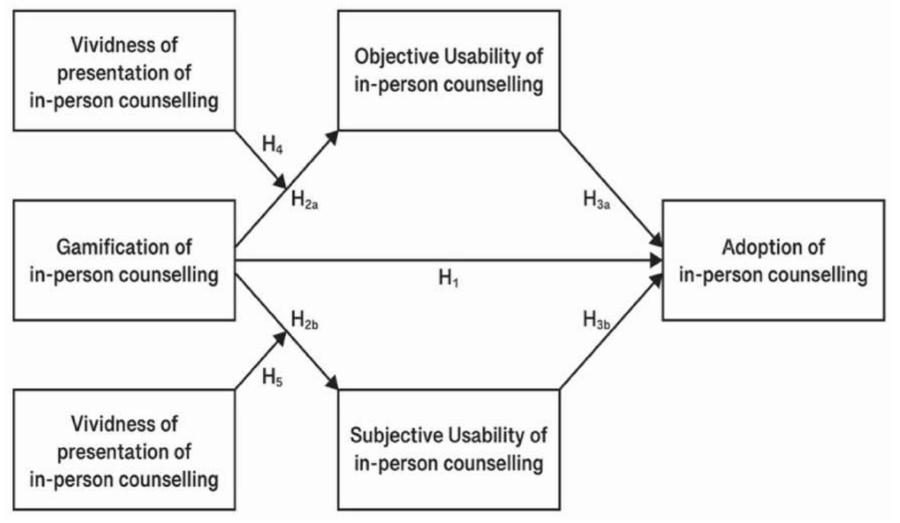
Figure 3. Adoption of in-person counseling as the function of the gamification of in-person counseling, the objective usability of in-person counseling, the subjective usability of in-person counseling, and the vividness of presentation of in-person